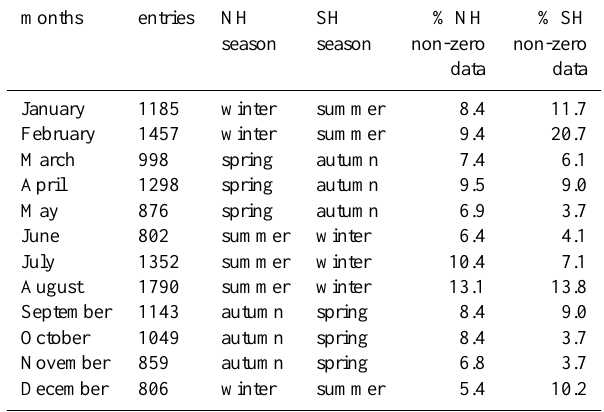
Table 6. Percentage distribution of non-zero data entries with re- spect to month for the Northern (NH) and Southern (SH) Hemi-